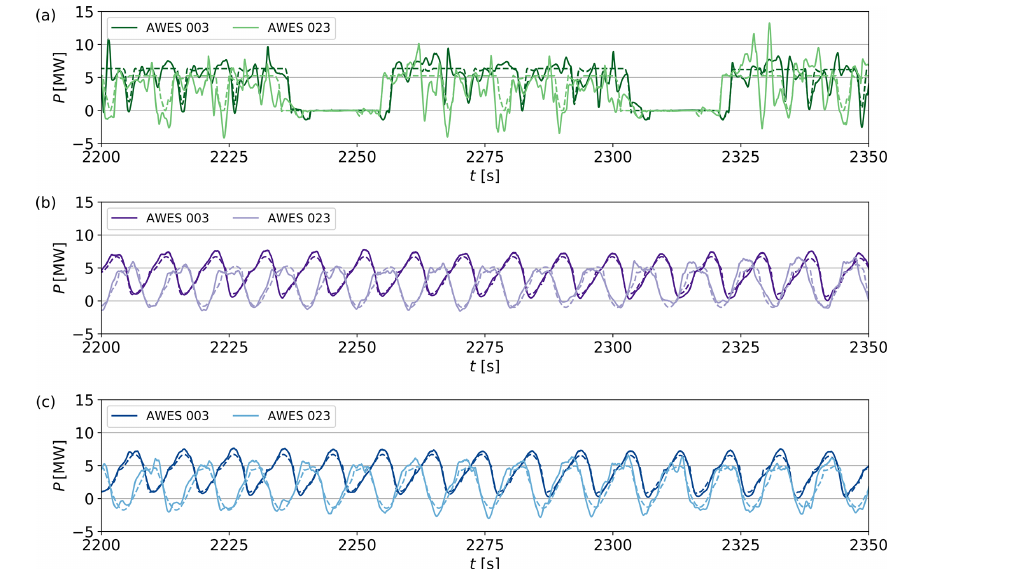
Figure 19. Time series of mechanical power P monitored by the front and rear AWE systems of the central park column ( x = 2000m) for the AWE parks L1 (a) , D1 (b) , and D2 (c) . The coloured dashed lines show the reference quantities of the tracked